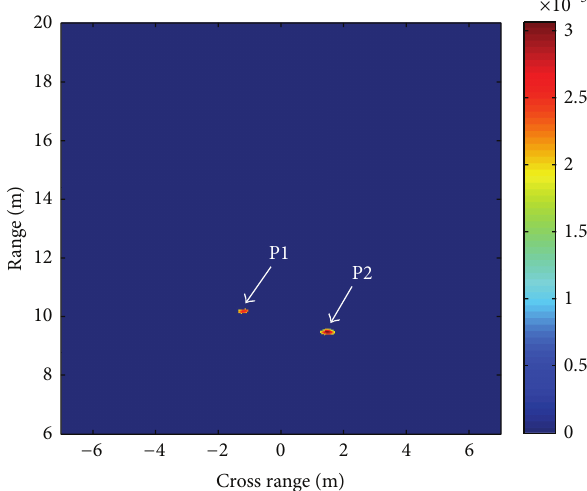
Figure 16: Imaging result processed by the proposed method in this